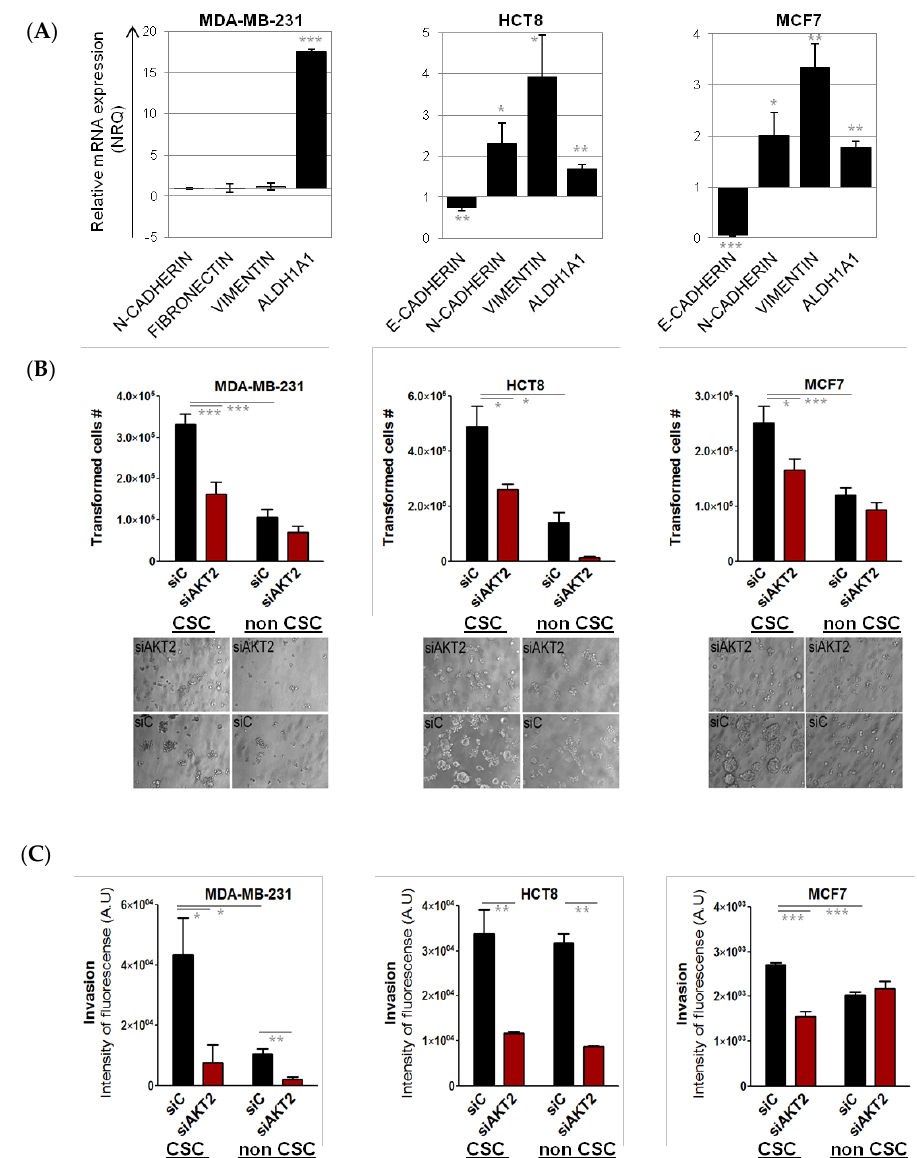
Figure 6. Effects of AKT2 silencing in MDA-MB-231, HCT-8, and MCF-7 CSC. MDA-MB-231, HCT-8, and MCF-7 CSC were separated from non-CSCs and the relative EMT gene expression profile was quantified by qPCR. The presented values are relative to their non-CSC population ( A ). Anchorage-independent growth assay: The graph represents the number of cells capable of anchorage-independent growth, comparing CSCs and non-CSC transfected with siAKT2 and control siRNA (siC). Images are photographs of colonies formed after seven days of incubation with siAKT2 and siC ( B ). Invasion assay: The graph represents the number of cells that demonstrated invasive capacity comparing CSC and non-CSC transfected with siAKT2 and siC ( C ). Results are expressed as NRQ (relative normalized quantities) mean ± SEM ( n ≥ 3); (* p < 0.05; ** p < 0.01, *** p < 0.001).